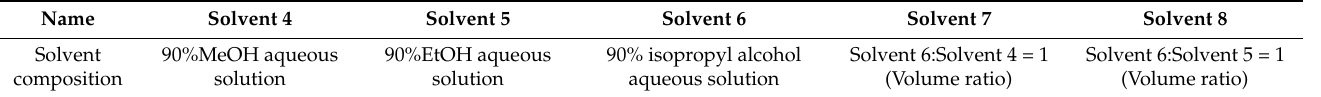
Table 3. Investigation of different solvents in second crystallization.